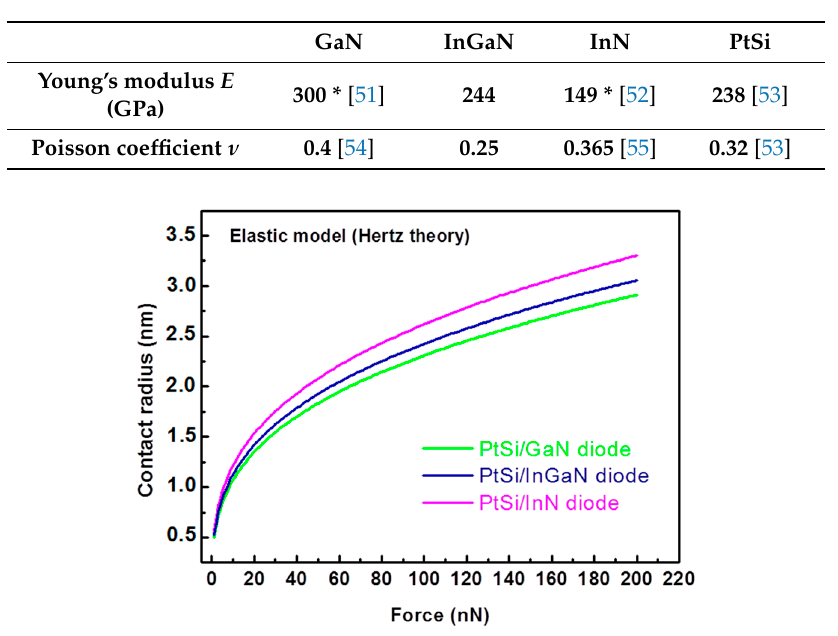
Figure 6. Calculation of the contact radius between PtSi AFM tip and GaN (green line), InN (pink line) and InGaN (blue line) NWs as a function of the applied force. The Hertz theory has been used with the material setting from Table 2.